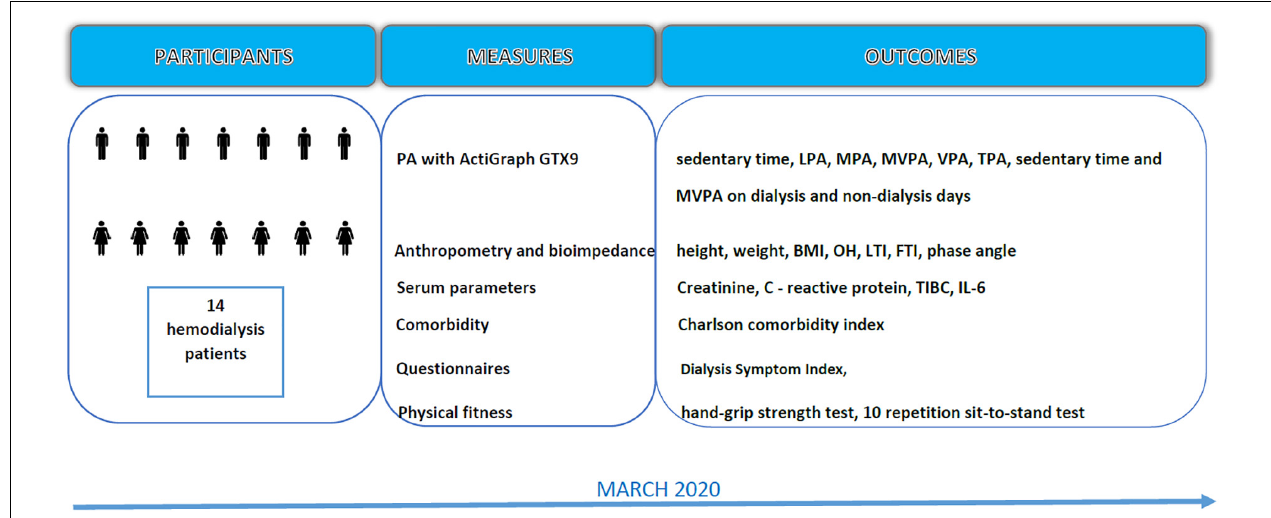
FIGURE 1 | Data collection flowchart. LPA, light physical activity; MPA, moderate physical activity; MVPA, moderate to vigorous physical activity; TPA, total time physical activity; BMI, body mass index; OH, over hydration; LTI, lean tissue index; FTI, fat tissue index; TIBC, total iron binding capacity; IL-6, interleukin